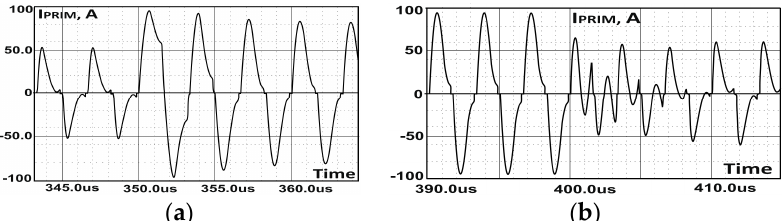
Figure 14. Experimental waveforms of the primary coil current at the variation of matching capacitor: ( a )-from 25% C 1 to 100% C 1 and ( b )-from 100% C 1 to 25% C 1 .